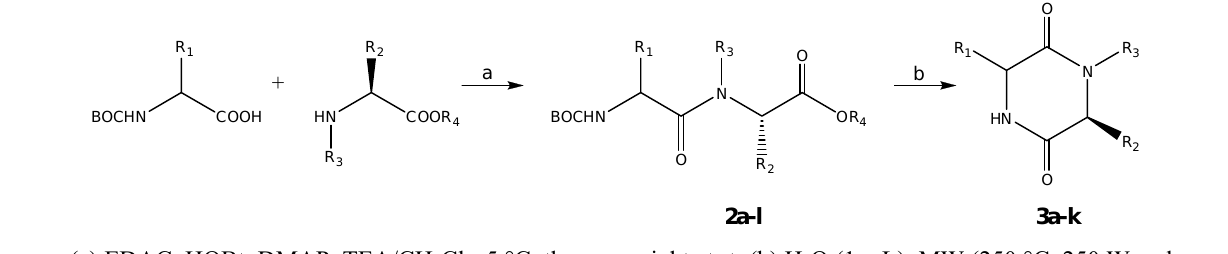
Table 2. Coupling of amino acids and ring closure under microwave irradiation. a